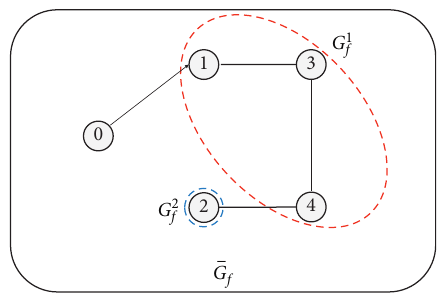
Figure 2: The graph G